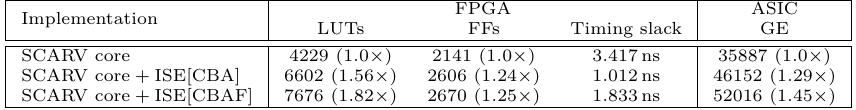
Table 2: Synthesis results for the ISE, as integrated into the SCARV core: the rows capture 1) the baseline core with no ISE, 2) the baseline core plus ISE with C, B, and A classes, and 3) the baseline core plus ISE with C, B, A, and F classes. Note that timing slack is quoted for a frequency of f = 50 MHz . for FPGA, while the ASIC designs have been all synthesized imposing a clock of